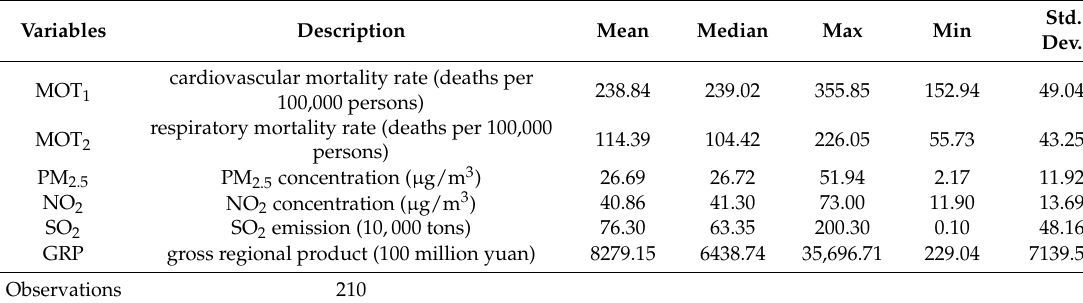
Table 2. Descriptive statistics for variables in panel threshold regression